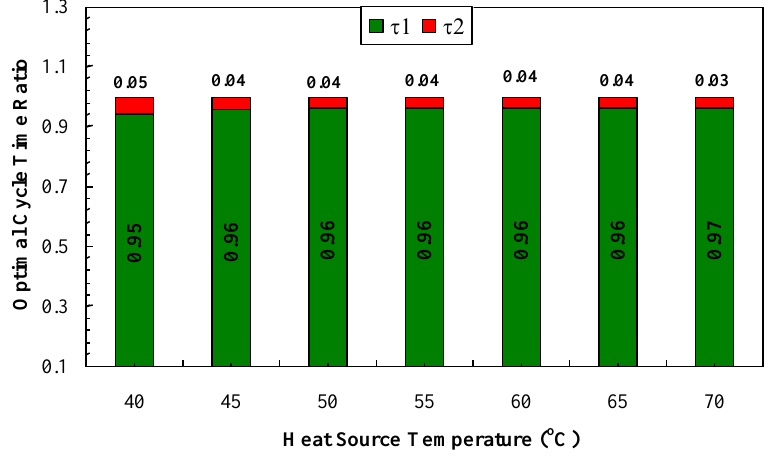
Figure 7. Variation of chilled water flow rate with heat source